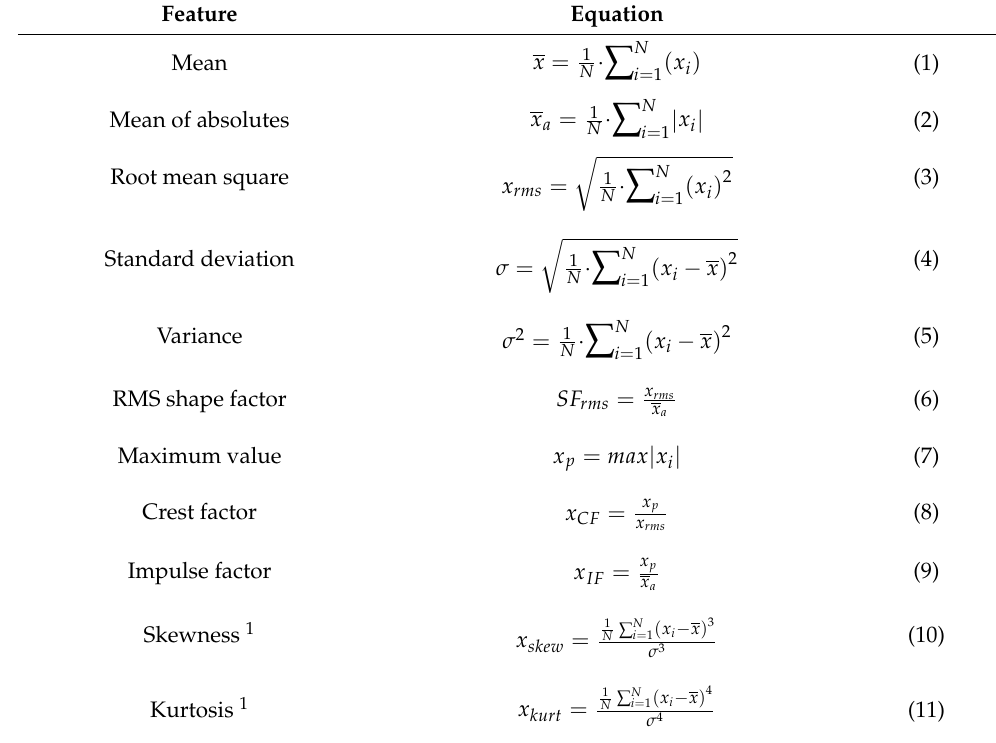
Table 2. Statistical indicators adopted for this